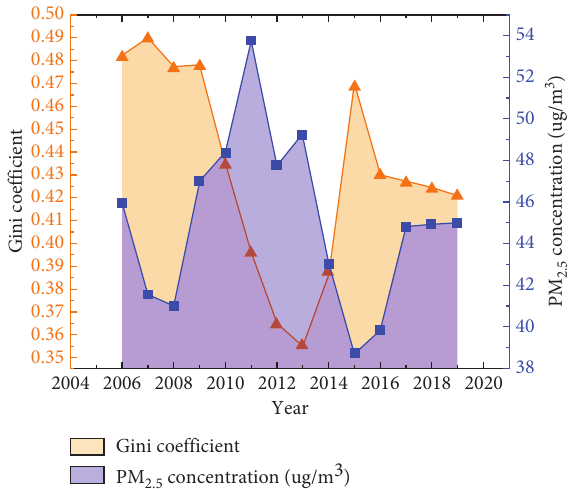
Figure 8: The Gini coefficient and the PM Jiangsu.